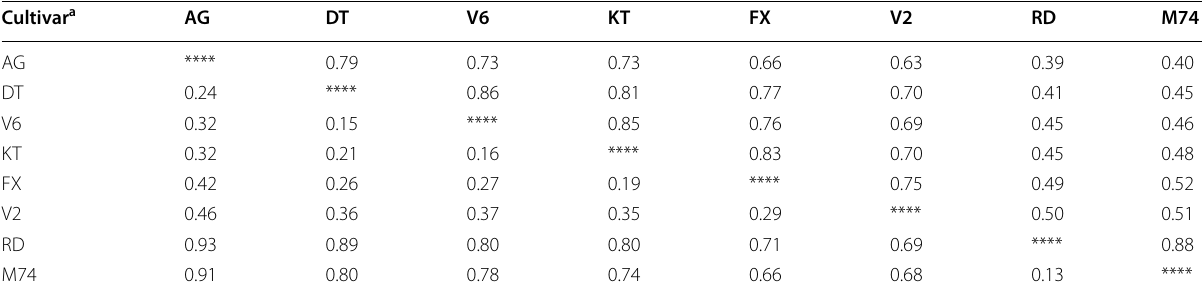
a The names of cultivars are represented by an abbreviation (see Table 1)